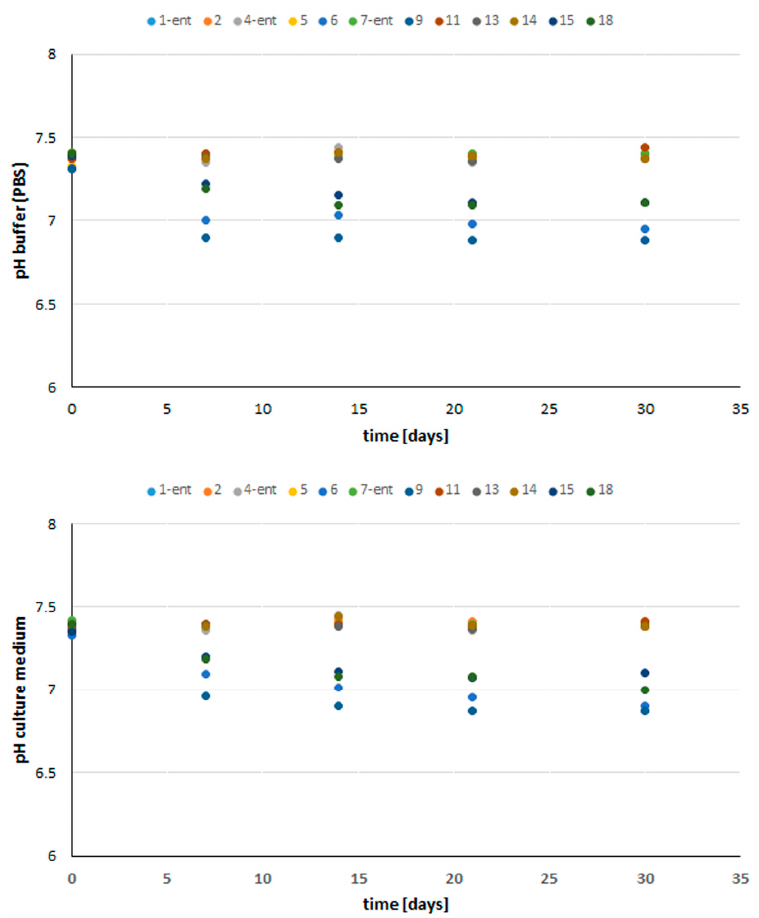
Figure 6. Stability of selected peptides in PBS buffer and culture medium.